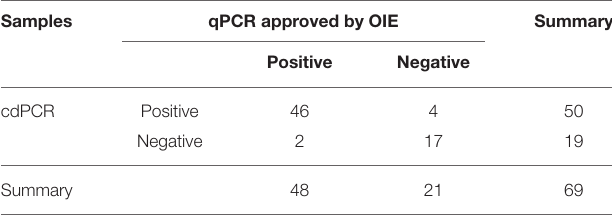
TABLE 3A | Testing of clinical samples by cdPCR and qPCR assay approved by OIE.